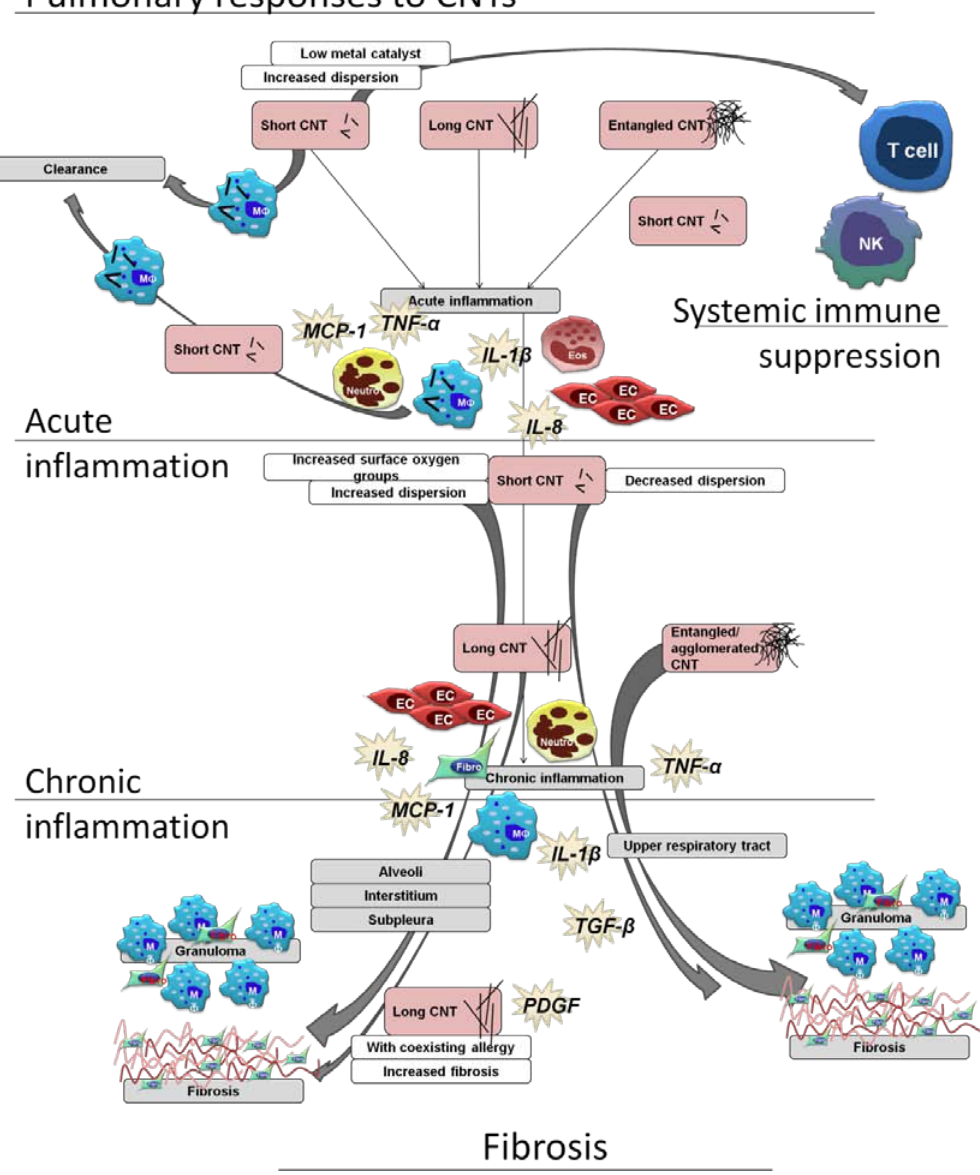
Figure 2. Schematic view of pulmonary immune cell responses related to CNT characteristics, using a selection of the literature reviewed in this article. A range of responses can be seen, with the secretion of both pro-inflammatory and pro-fibrotic mediators, and effects upon epithelial cells (EC), T cells, monocytes (MO), macrophages, natural killer cells (NK), eosinophils (Eos), and neutrophils (neutro). Short, long, and entangled CNTs all are able to induce acute and chronic inflammation, and all able to induce granulomas and fibrosis. Fibrotic lesions induced by aggregated and entangled CNTs are restricted to the upper airways, while well-dispersed short and long CNTs are found within the alveoli and interstitium, with associated fibrosis. Allergen sensitization is shown to enhance inflammation and fibrosis induced by CNTs, as is CNT length. At times, a systemic immune effect can be observed without obvious pulmonary inflammation.